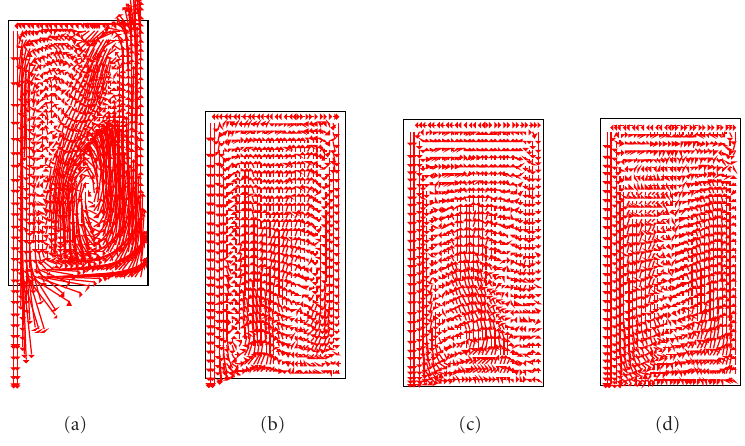
Figure 6: Velocity vector on meridional plane in drum with A = 1 under spin-down process from 5 s/rev to zero: (a) t = 0 seconds, (b) t = 6 seconds, (c) t = 20 seconds, and (d) t = 40 seconds.